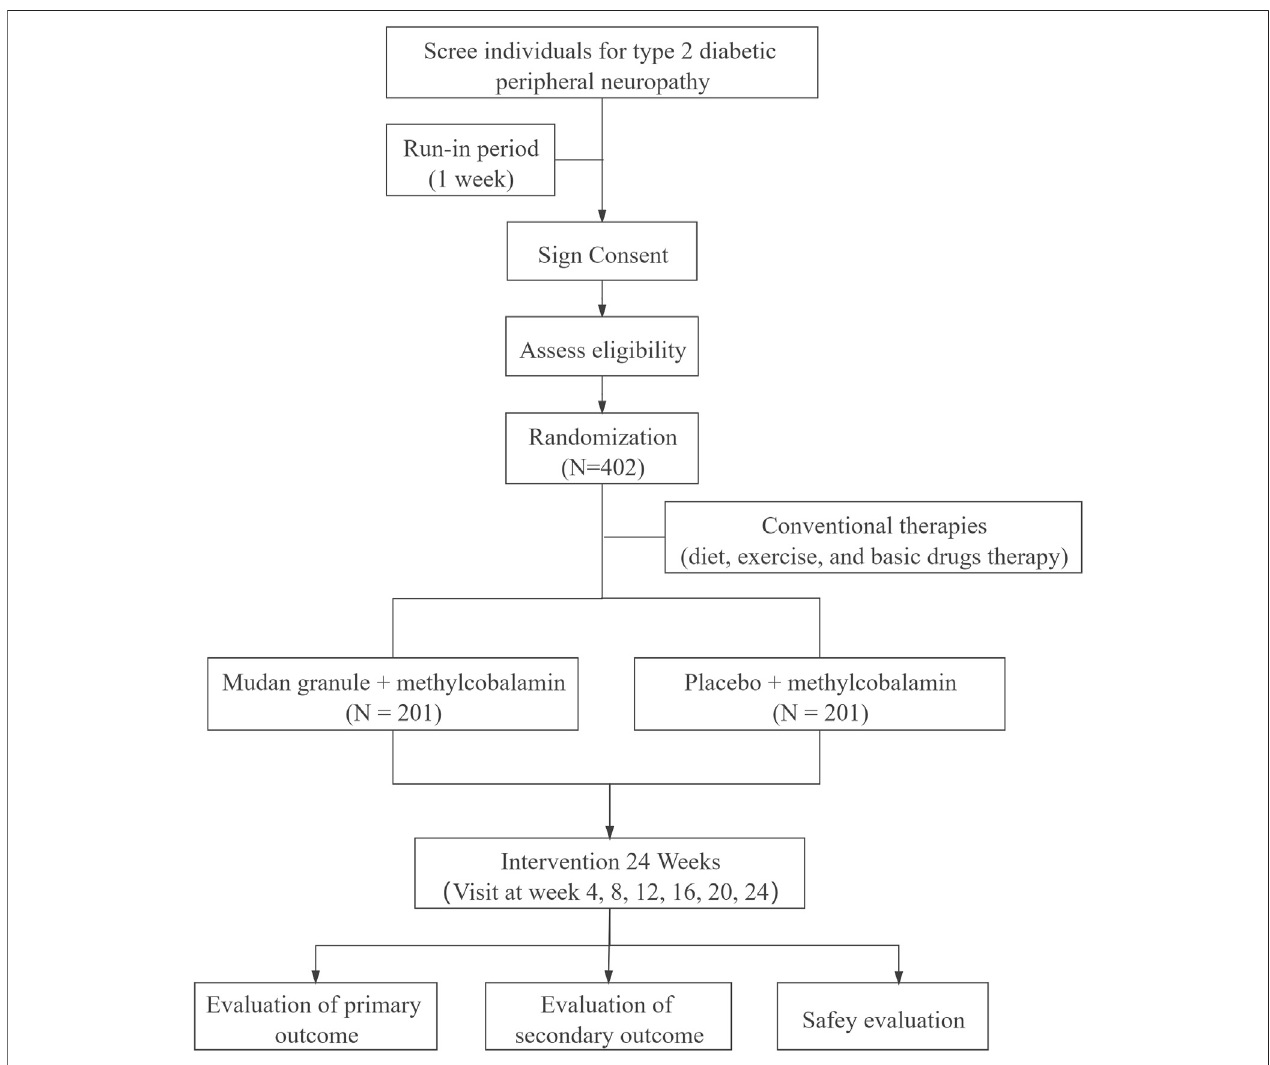
FIGURE 1 | The fl ow diagram of this